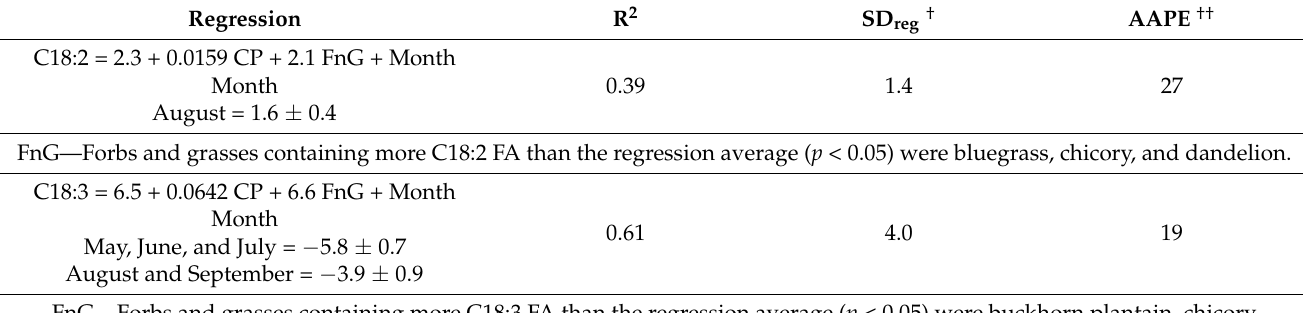
Regressions describing the effect of CP, Month, and pooled species group on the FA content in the grass, legume, and forb forage accounted for 39%, 61%, and 62% of the variation in C18:2, C18:3, and total FA, respectively (Table 4). The unexplained regression errors, expressed as the SD about the regressions (square root of the mean square error), were 1.4, 4.0, and 5.1 g kg − 1 DM; or 13%, 11%, and 11% of the observed ranges in C18:2, C18:3, and total FA, respectively. The forage CP content accounted for much of the monthly